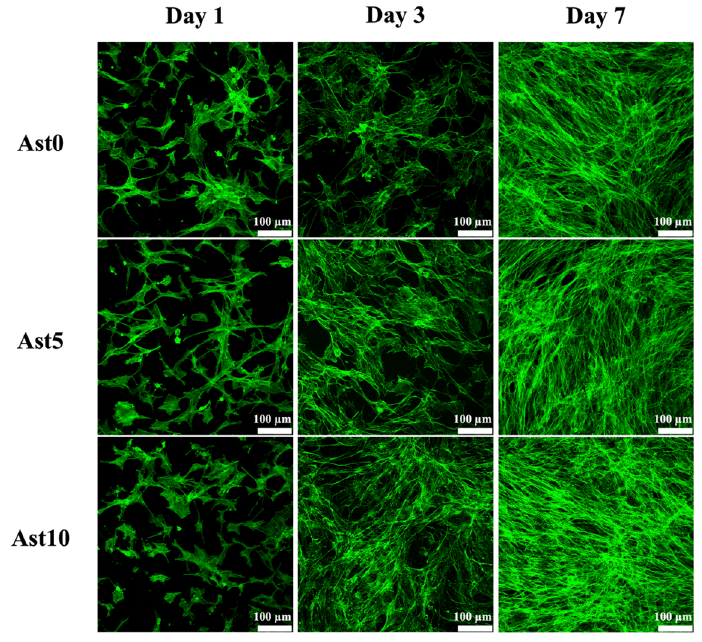
Figure 6. The morphology of RSCs cultured on 3D-printed Ast-containing nerve conduits for different time points.